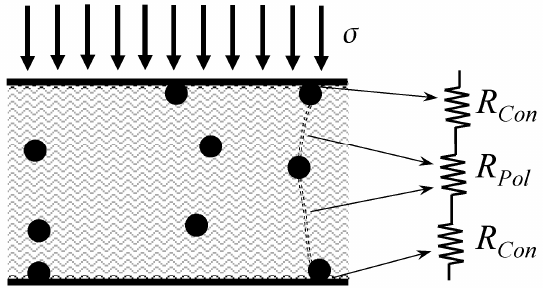
Figure 5. Schematic view of an FSR representing the contact resistance ( R Con ) and the resistance of the polymer composite ( R Pol ) as in Equation (9). Direction of applied stress ( σ ) is signaled with arrows.